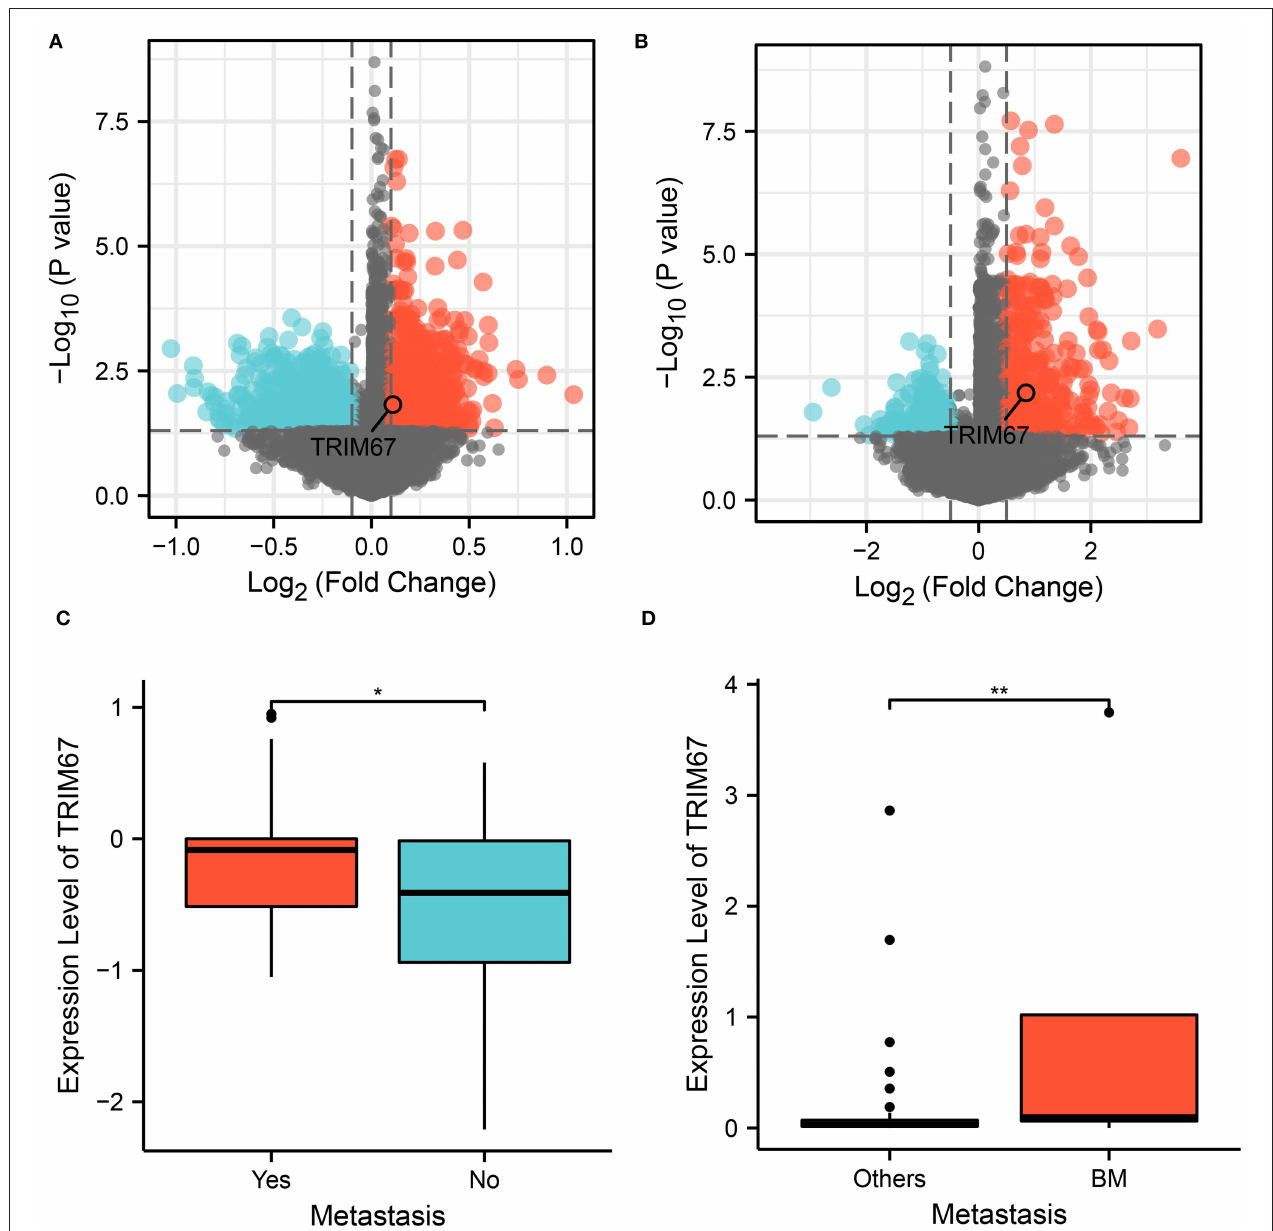
FIGURE 1 | Analysis of variance showed that TRIM67 was upregulated in both DM and BM. (A) Volcano plot showing differentially expressed genes between the DM and nDM groups, where TRIM67 was found to be upregulated in DM; (B) Differential expression analysis between BM and nBM groups showed that TRIM67 was upregulated in BM; (C) There was a statistically significant difference in TRIM67 expression between the DM and nDM groups ( p = 0.021); (D) There was a statistically significant difference in TRIM67 expression between the BM and nBM groups ( p =